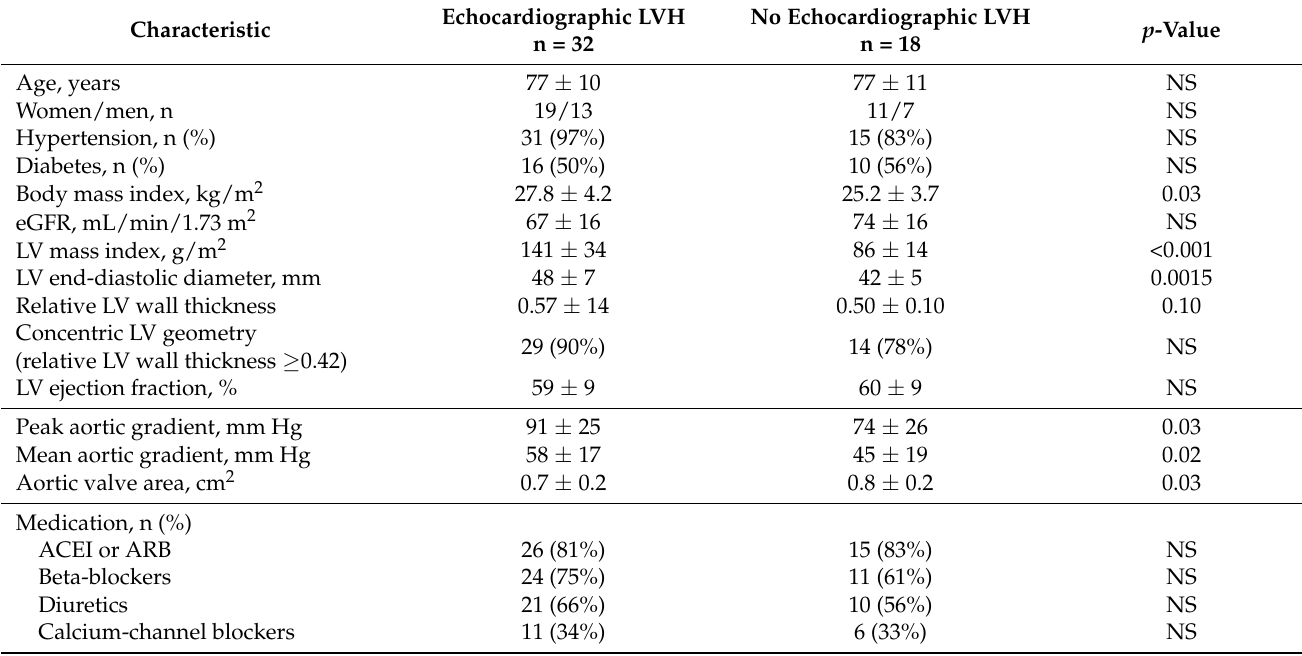
Table 1. Characteristics of patients according to echocardiographic